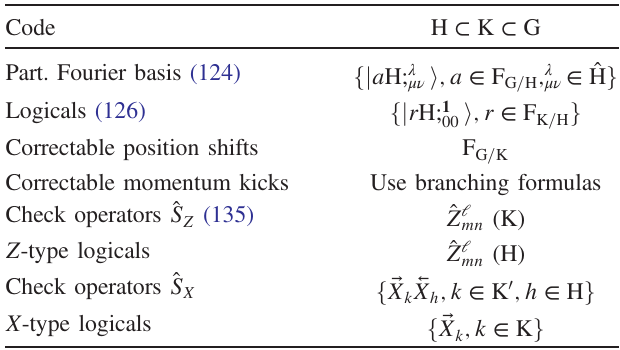
TABLE III. List of elements of a H ⊂ K code on G from ˆ Sec. VA. The set H consists of (equivalence classes of) all irreps of H, F is the Voronoi cell of the identity (see Appendix B), G = K and K 0 ⊂ K consists of all elements of K that map to identity when projected onto the logical